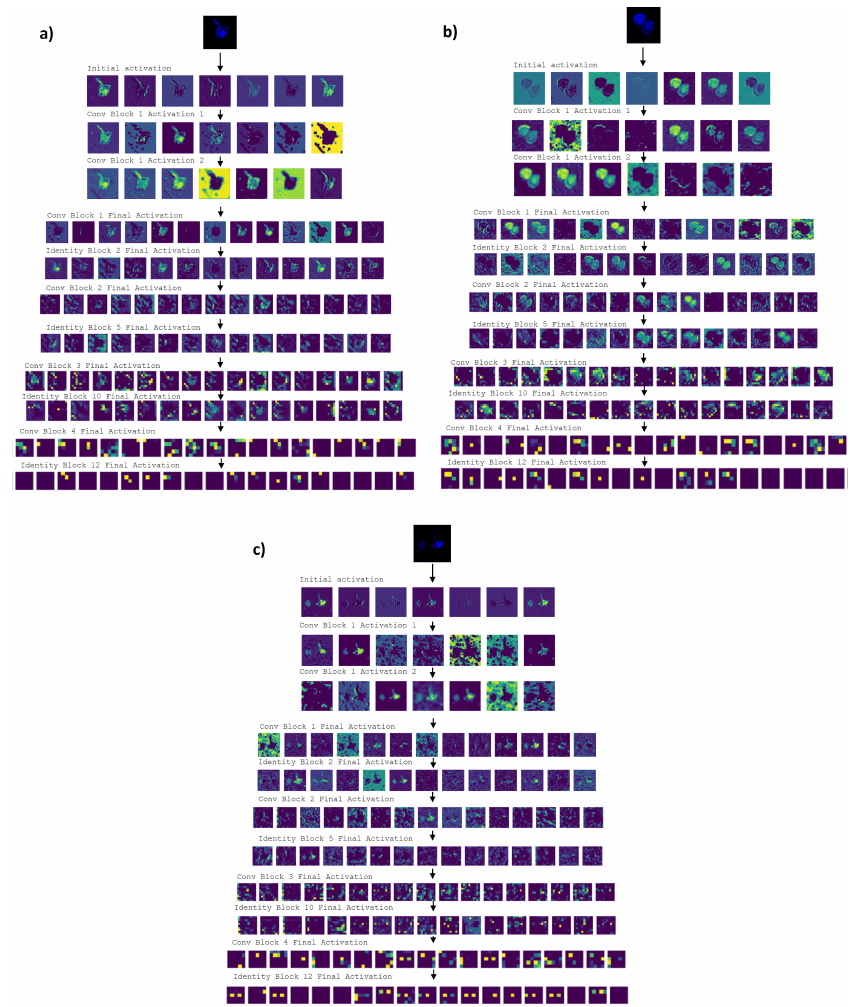
Figure 10. Activations throughout the model ResNet-IFT testing. ( a ) Activations of a PSP image using ResNet-IFT with D2. ( b ) Activations of an AD image using ResNet-IFT with D1. ( c ) Activations of an AD image using ResNet-IFT with D3. From the fifth row of ( a – c ) we can see that features that are not visible in the original image start to be taken into account for the activation of the